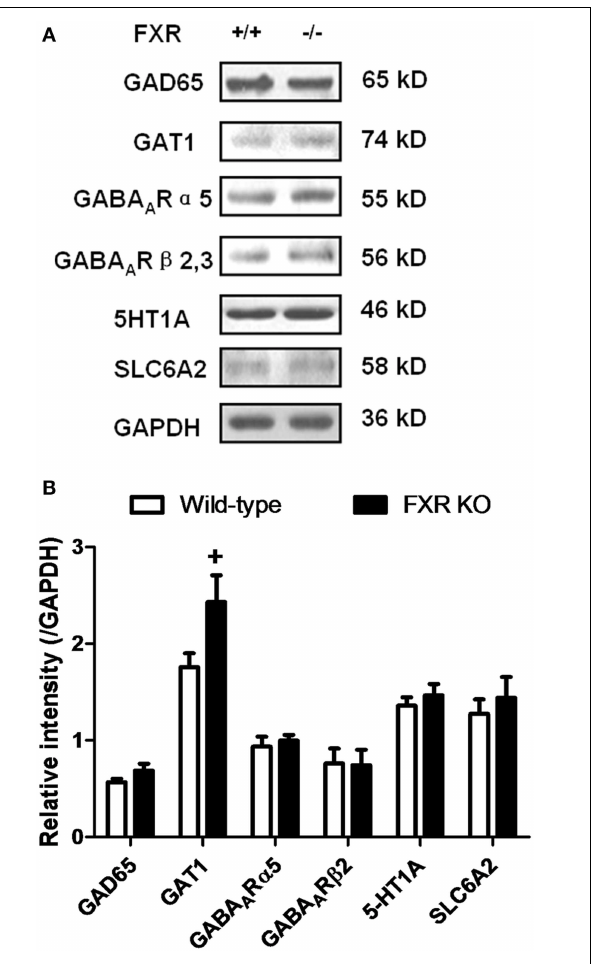
FIGURE 7 | FXR KO increased cerebellar GAT1. (A) Western blotting analysis of GAD65, GAT1, GABA A R α 5, GABA A R β 2/3, 5-HT1A, and SLC6A2. (B) Gray intensity comparison. N = 8 /group; + p < 0 . 1